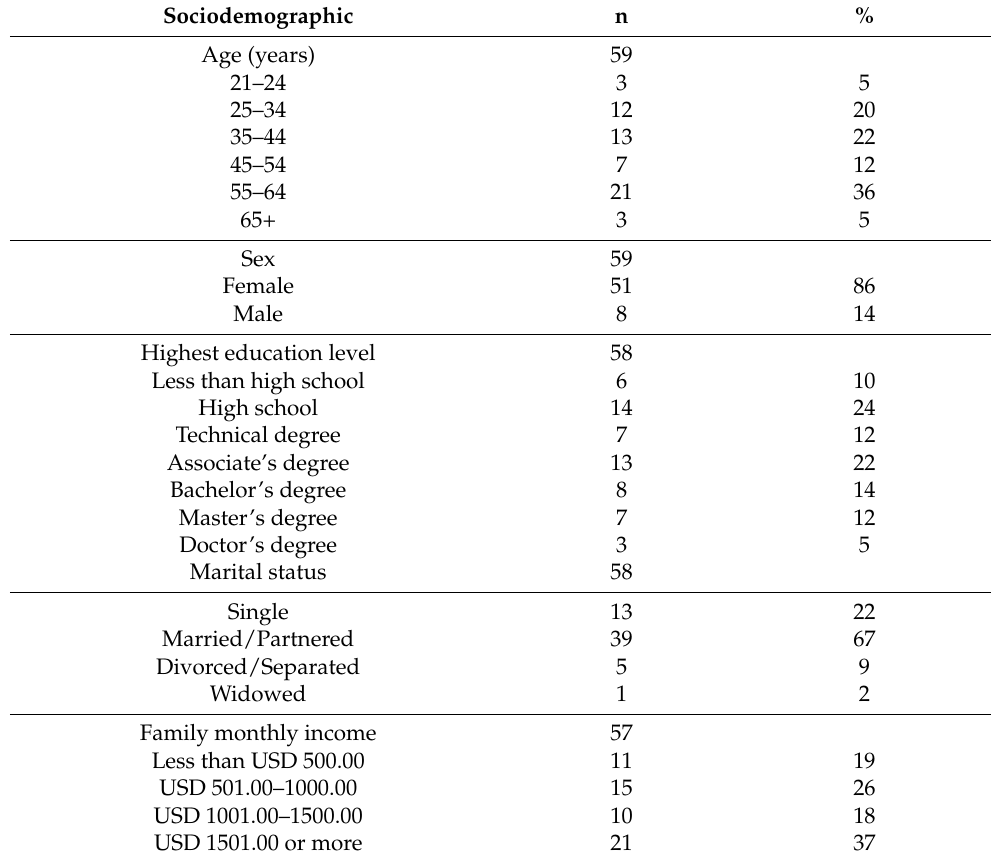
Table 1. Focus groups sociodemographic characteristics.